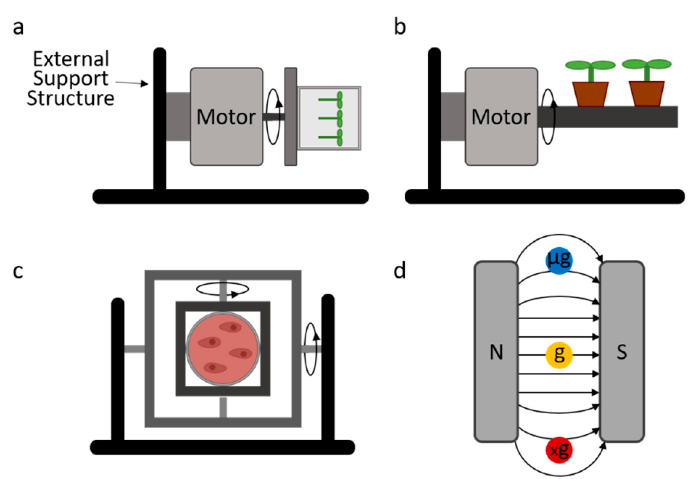
Figure 1. Ground microgravity simulators. Schematic representation of ( a ) 1D clinostat; ( b ) 2D clinostat; ( c ) 3D clinostat/RPM (random positioning machine); and ( d ) diamagnetic levitation system. Clinostats and RPMs simulate the absence of a directional gravity input by averaging the gravity vector through rotation around one or two axes over time. Diamagnetic levitation compensates gravity at molecular level, by balancing the weight of water and biological tissues with the repulsive force exerted by a magnetic field. Within the magnetic field, a specimen can experience from zero ( µ g) to twice the gravity force (xg) depending on its position within the magnetic field